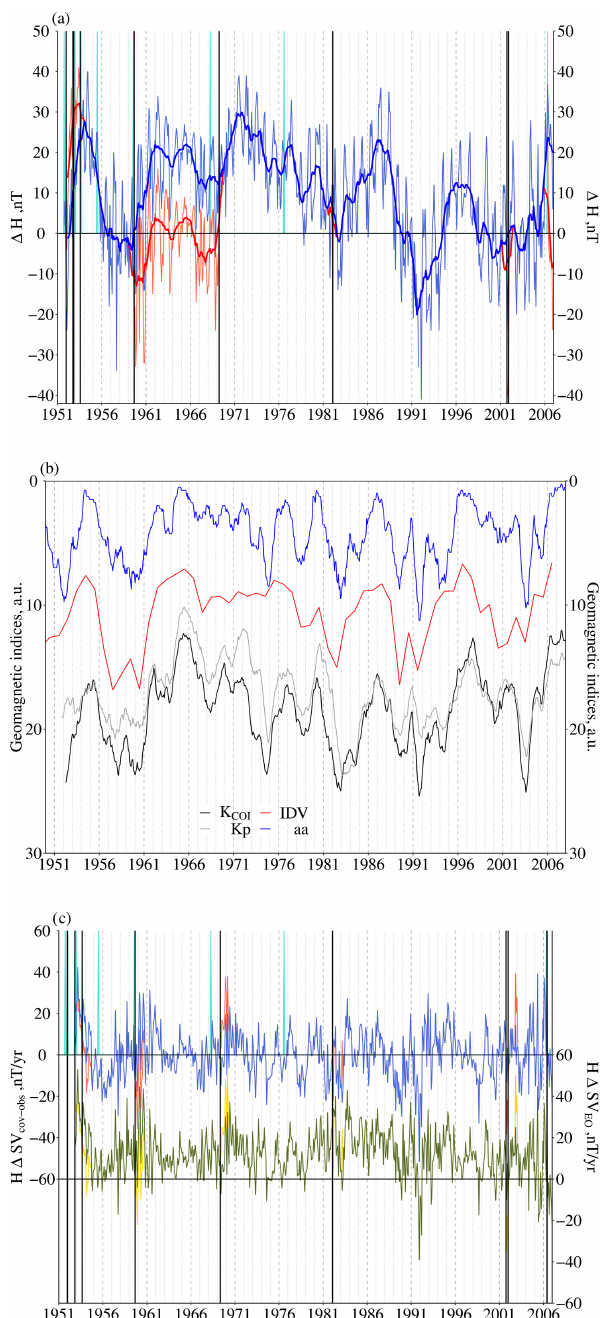
Figure 4. Same as Fig. 2 but for the COI I